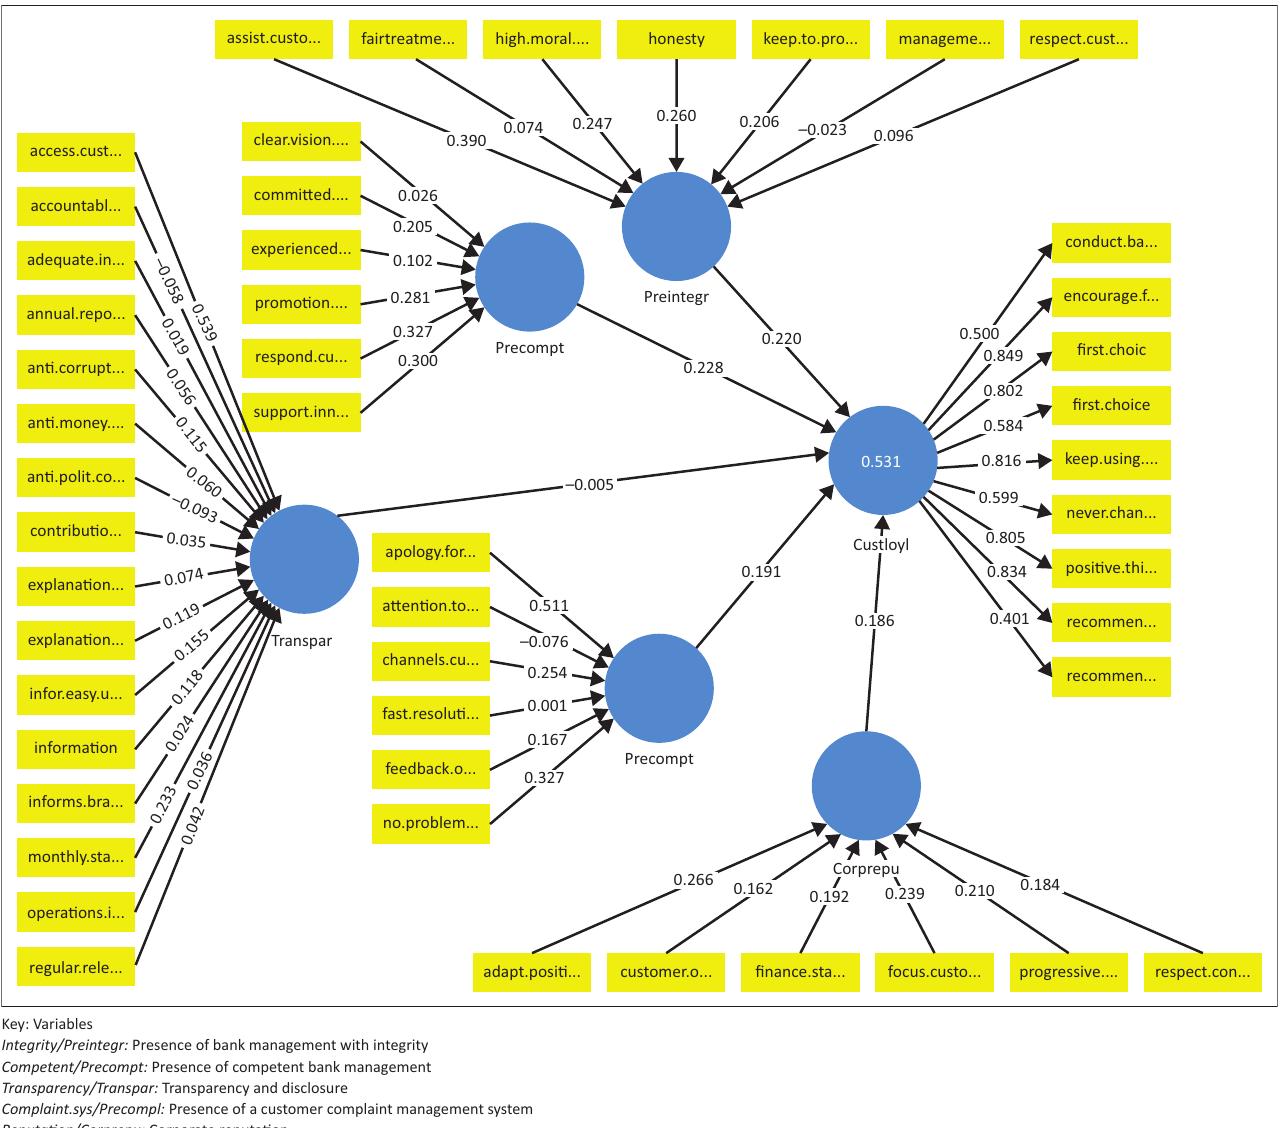
FIGURE 1: Partial least square structural equation model indicating the influence of corporate governance practices on customer TABLE 2: Path coefficients and total effects. FACTORS